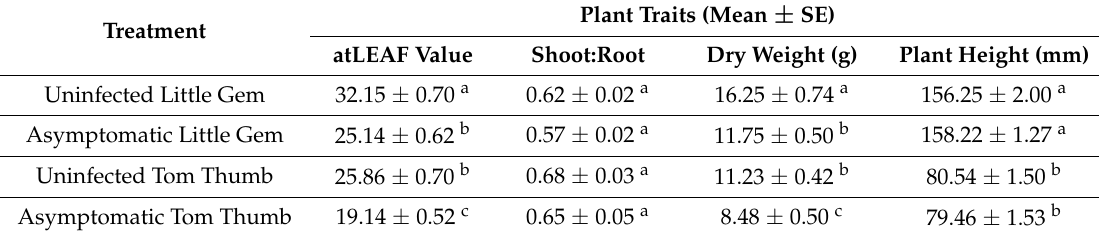
Table 2. The effect of asymptomatic B. cinerea infection and plant variety on plant traits. atLEAF value represents the amount of chlorophyll present in the plant leaf. For each parameter, differences among treatment were examined by post-hoc Tukey tests ( p < 0.05). Means within columns followed by the same letters are not significantly different.